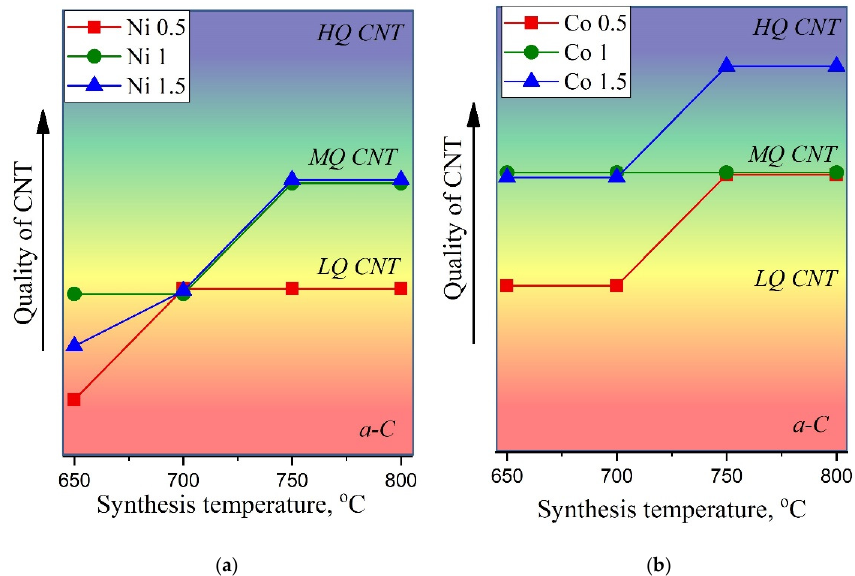
Figure 9. Dependence of the quality of CNTs on the synthesis temperature ( a ) and catalyst concen- tration ( b ). Where a-C—amorphous carbon, LQ CNT, CNT and HQ CNT—low, medium and high quality of CNT, respectively.